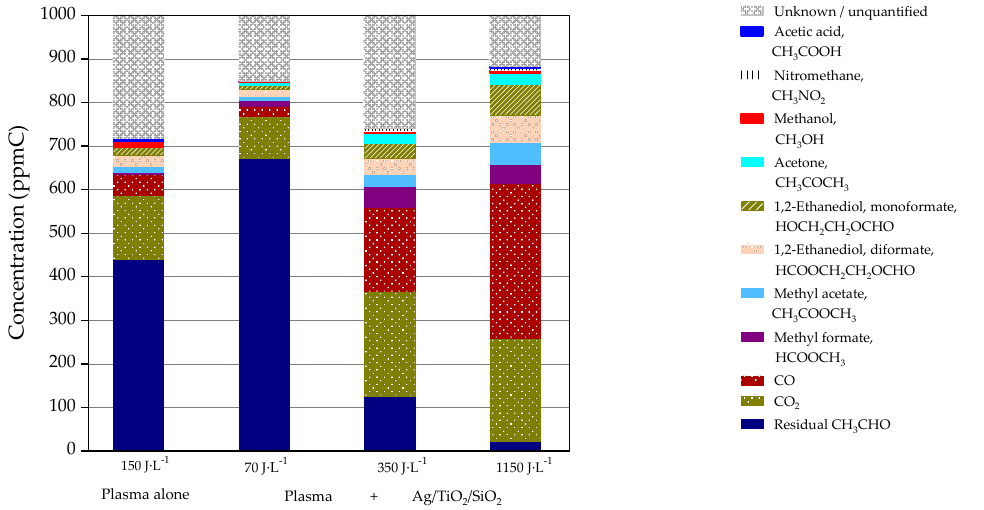
Figure 1. Comparison of the composition of the dielectric barrier discharge (DBD) reactor effluent obtained with the plasma-alone and the plasma-driven catalysis process, as a function of SIE.